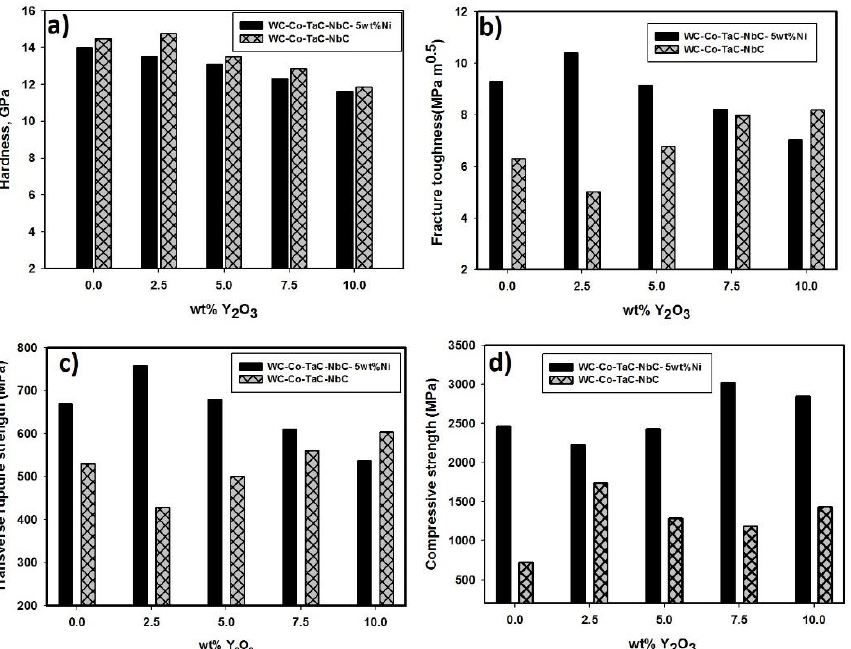
Figure 14. Mechanical properties of the consolidated composites with and without 5 wt% Ni at different Y 2 O 3 contents. ( a ) Hardness, ( b ) fracture toughness, ( c ) transverse rupture strength, ( d ) compressive strength.